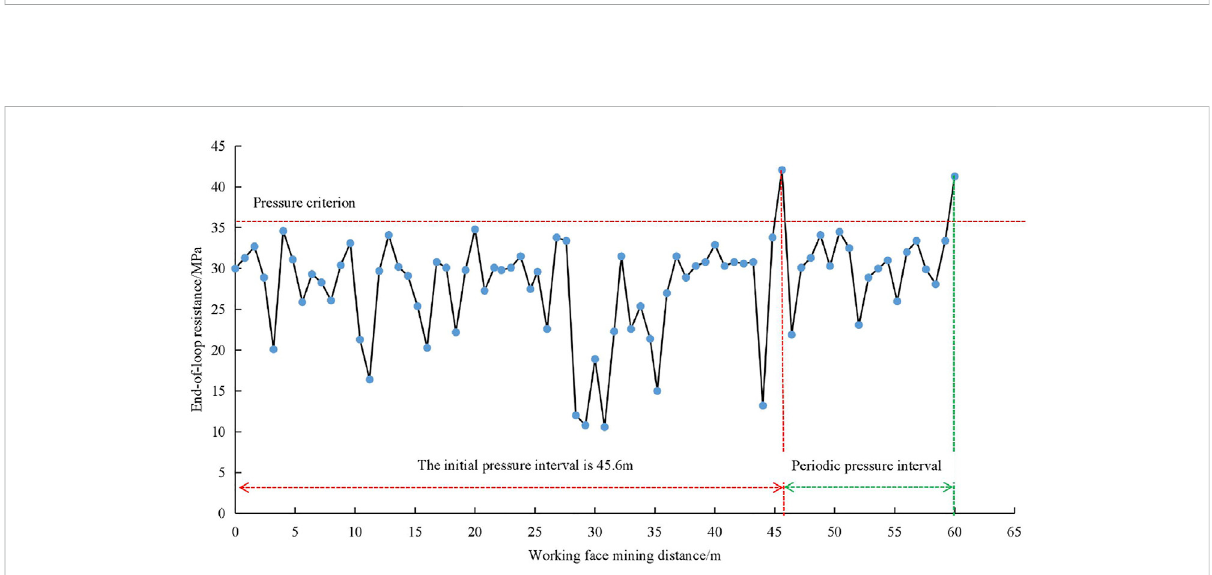
FIGURE 11 Curve of the end-of-loop resistance of the No. 90 hydraulic